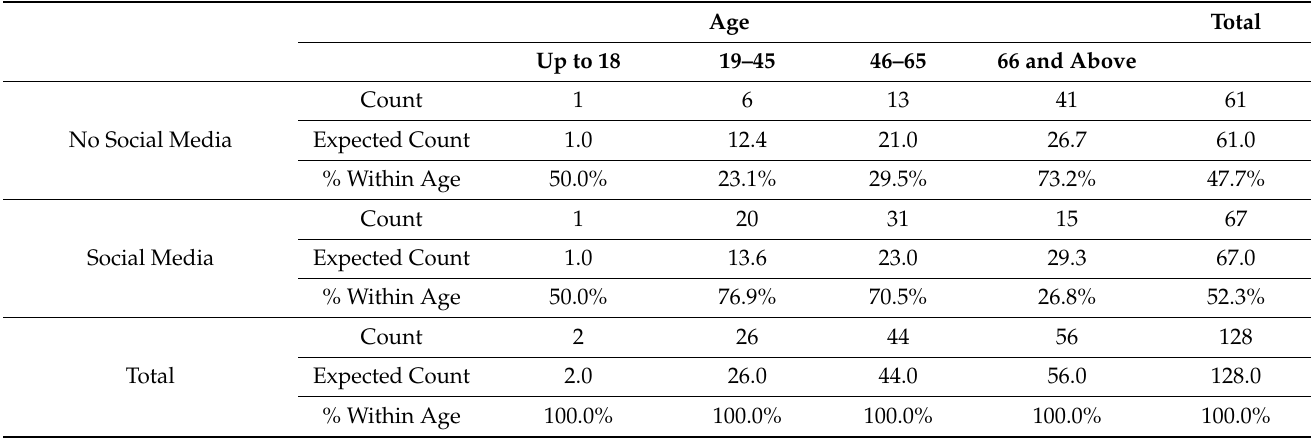
Table 3. Cross-tabulation results for using social media to increase participation in community outreach activities by